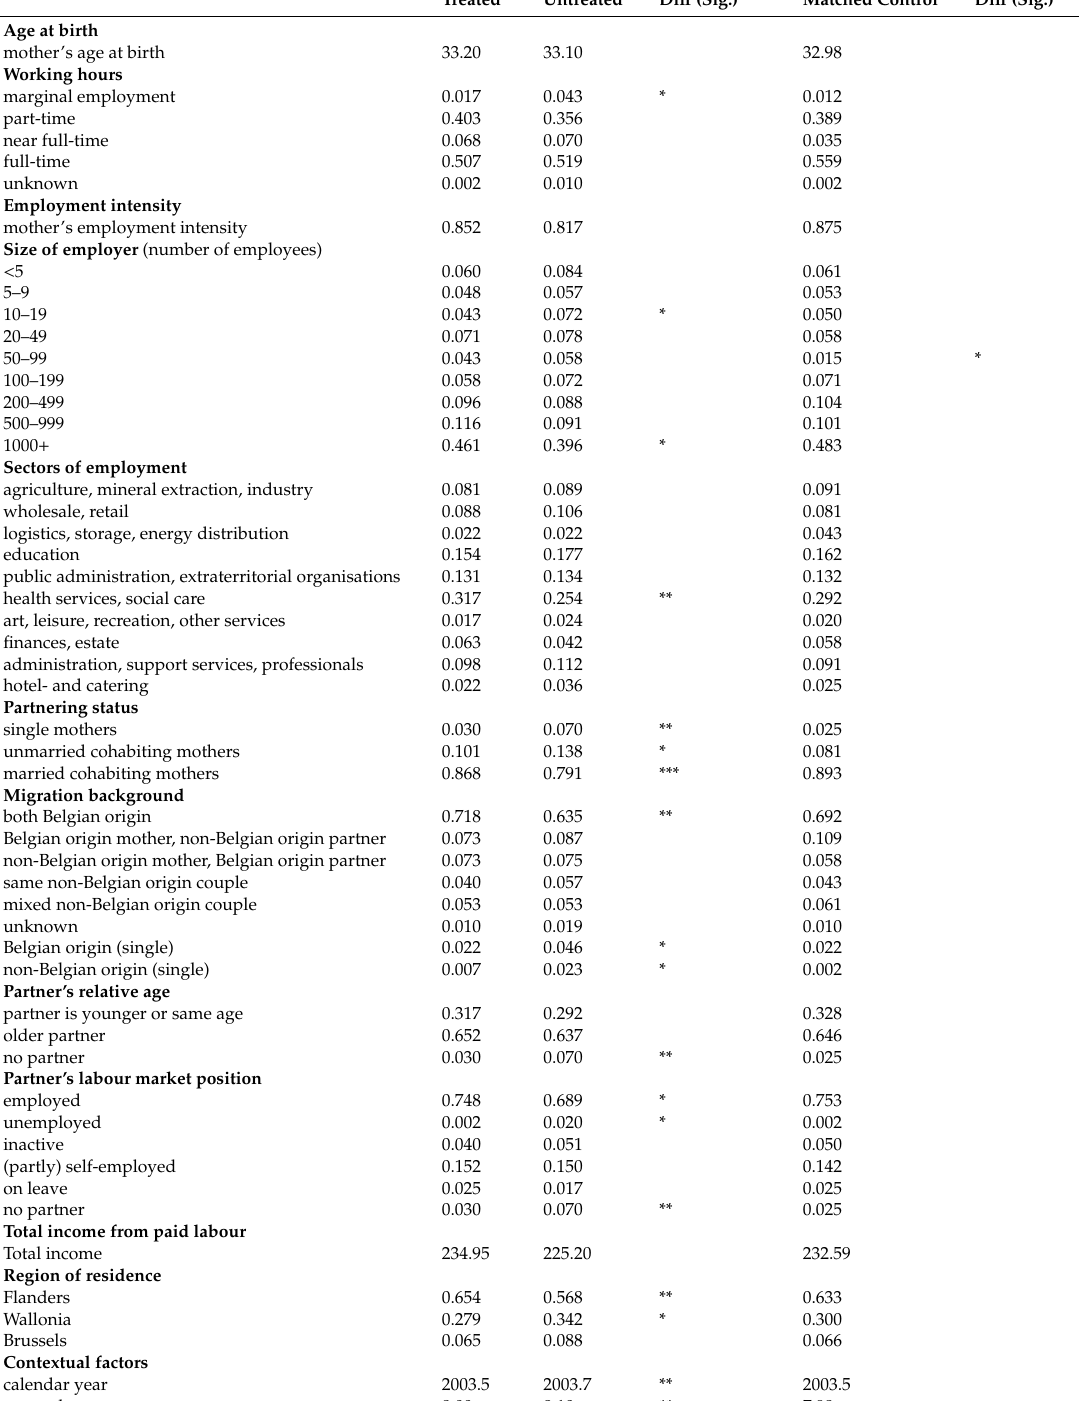
Table 3. Sample characteristics (means and proportions) for 1006 women who experienced a third birth in 2001–2005, Belgium. Treated Untreated Di ff (Sig.) Matched Control Di ff